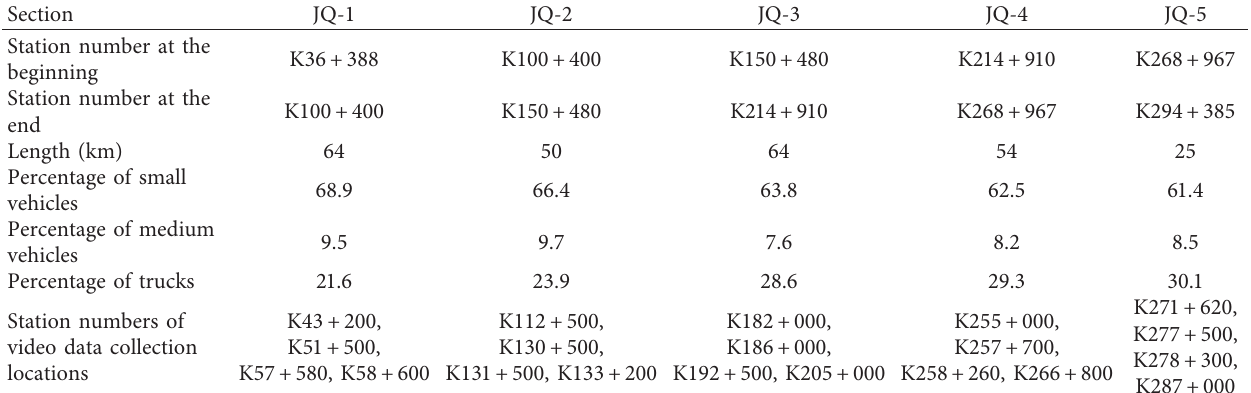
Table 2: Traffic data of each section.